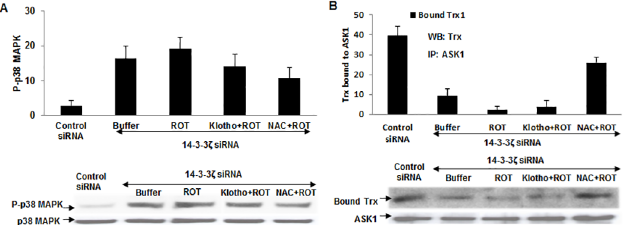
Fig 5. Effect of 14-3-3 ζ knockdown on Klotho signaling via ASK1 and p38 MAPK pathway. (A) Plots of phosphorylation levels of p38 MAPK in 14-3-3 ζ -depleted HEK 293 cells. Cells were pre-treated with either 200 pM secreted Klotho or 20 mM NAC for 40 min before the addition of 5 μ M ROT. Level of the phosphorylated protein was measured by Western blot using a phospho-14-3-3 ζ (Ser-58) antibody. The same membrane was stripped and re-probed with the total 14-3-3 ζ antibody to normalize for protein load. (B) Levels of Trx bound to ASK1 in 14-3-3 ζ -depleted HEK 293 cells treated with secreted Klotho, or NAC, or buffer control for 40 min as described in text. The Western blot profile is shown beneath.